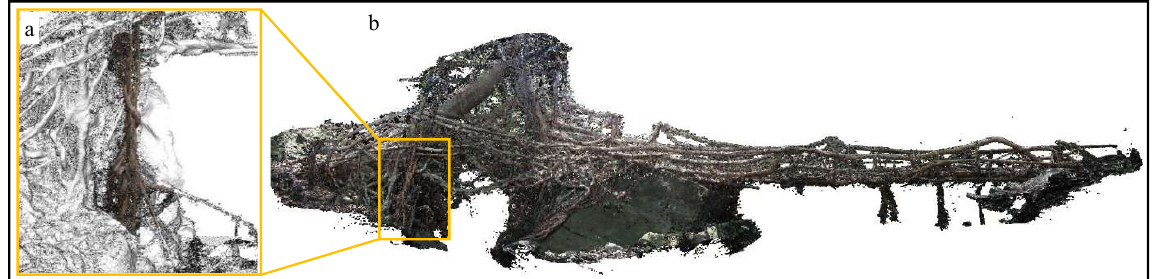
Figure 3: Umkar bridge in Siej village has young roots that are recently knotted (a), expected to grow in the coming years. An upstream perspective, through the hillside slope is achieved with photogrammetric survey (b).